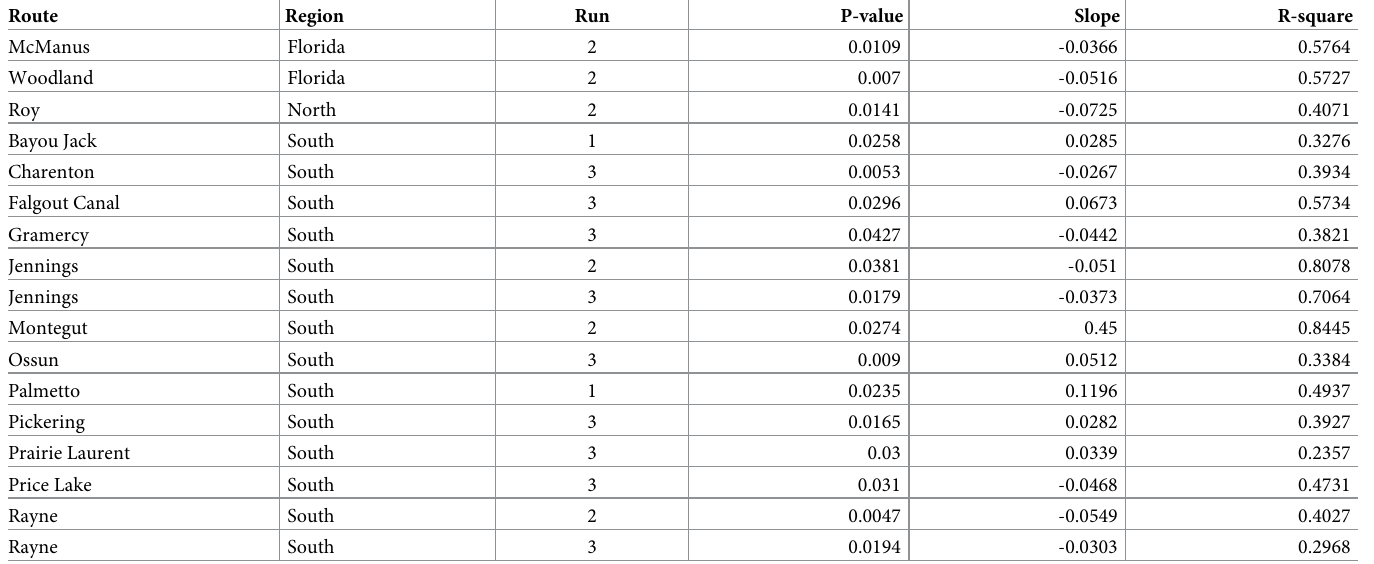
Table 8. Route-run Average Call Index (ACI) regressions.